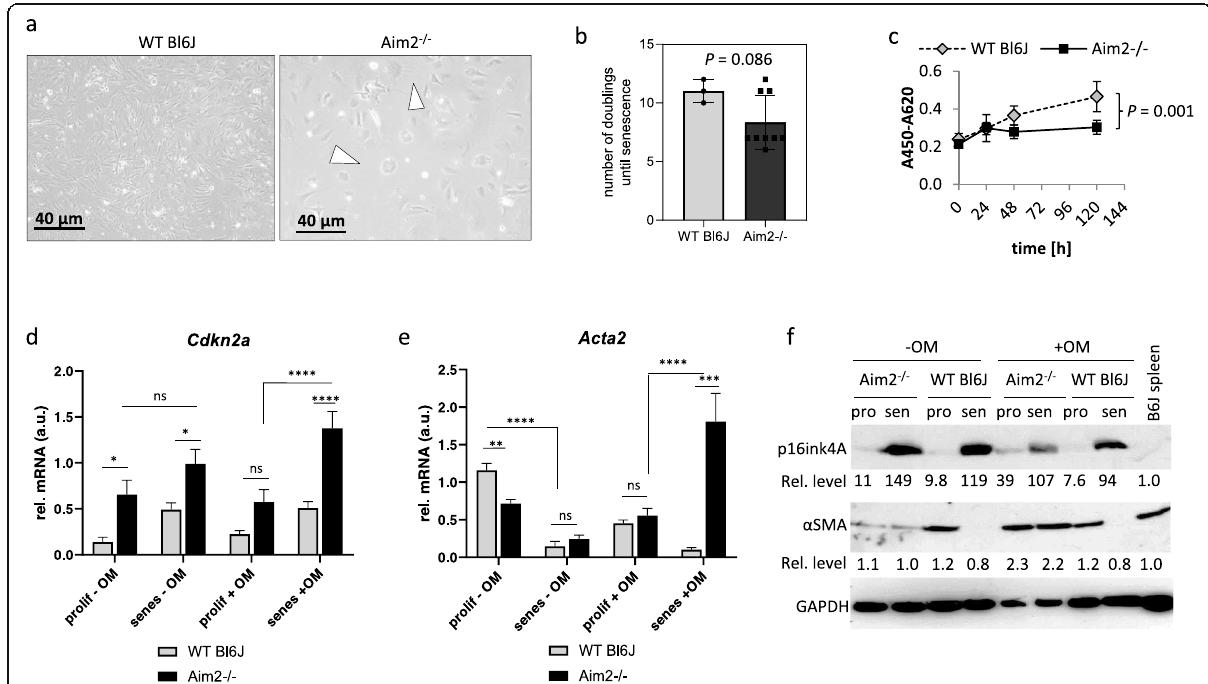
Fig. 1 Aim2 knockout affects the morphology, replicative potential and senescence of murine VSMC. VSMC were isolated from WT and Aim2 − / −